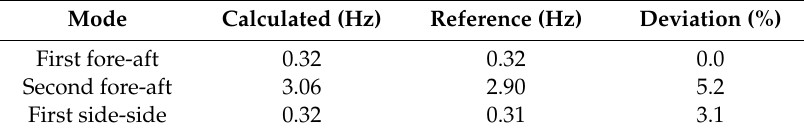
Table 2. Natural frequencies for the tower: single rotor configuration.